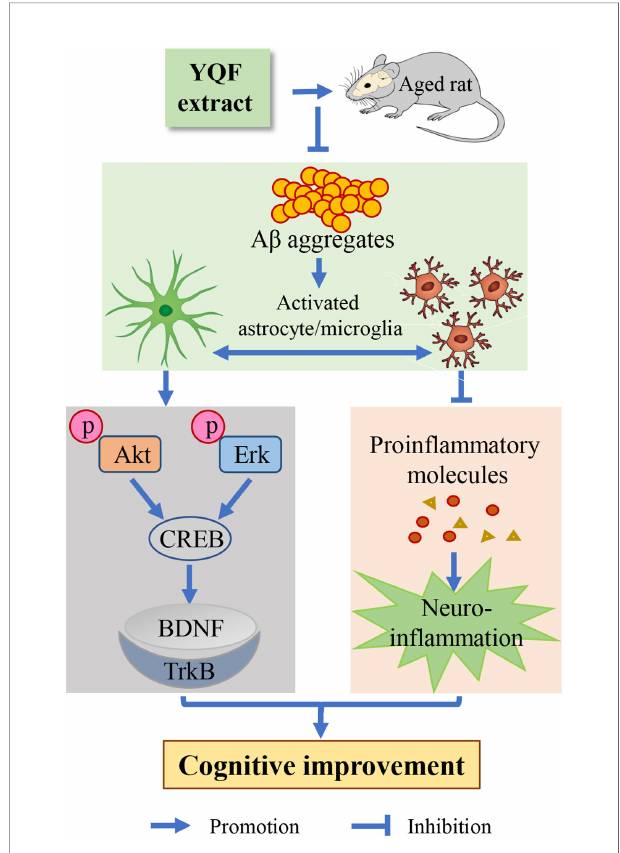
FIGURE 9 | Possible roleof microglia/astrocyte inthe onset/progression of the AD pathology through proin fl ammatory molecules mediated neuro-in fl ammation (Ahmadetal., 2019).A proposedpathway for YQF extract-inducedactivation of BDNF/TrkB to explains the cognitive improvement effects in aged